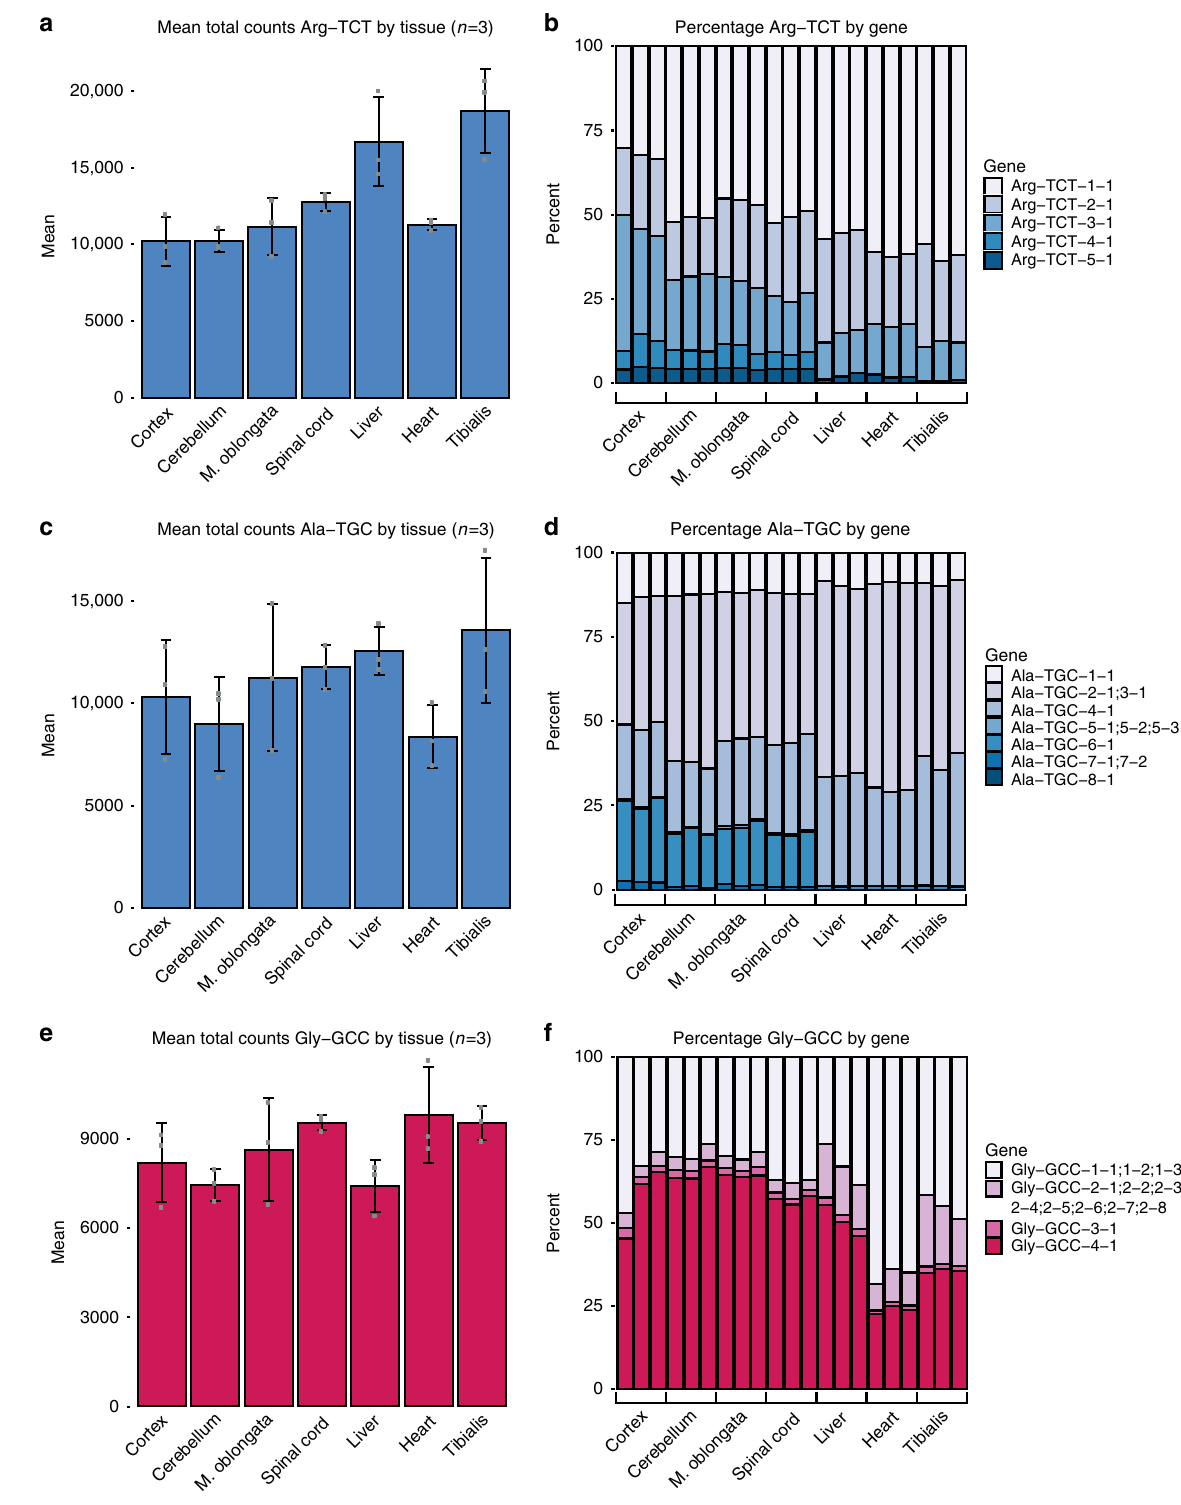
Fig. 5 Isodecoder pools comprising anticodon pools differ across tissues. Bar charts with center showing mean total Arg-TCT ( a ), Ala-TGC ( c ), or Gly- GCC ( e ) reads per million across mouse tissues. Error bars represent the standard deviation of N = 3 biological replicates. Stacked bar charts for percentage of each isodecoder contributing to the pool of Arg-TCT ( b ), Ala-TGC ( d ), or Gly-GCC ( f ) across mouse tissues. Bar charts with blue shading represents examples of anticodon pools with CNS-enriched isodecoders. Red shading represents an example of an anticodon pool with non-CNS-enriched